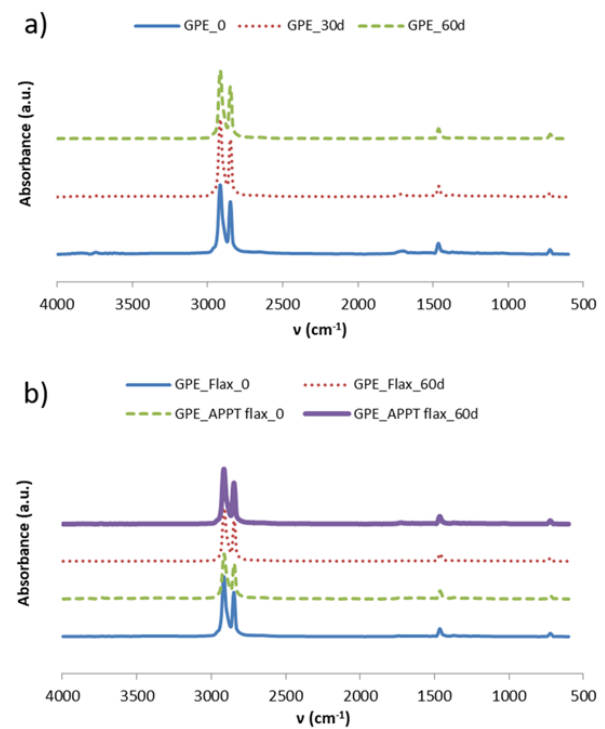
Figure 11. FTIR spectra for GPE materials before and after aging time. ( a ) GPE and ( b ) GPE composites.